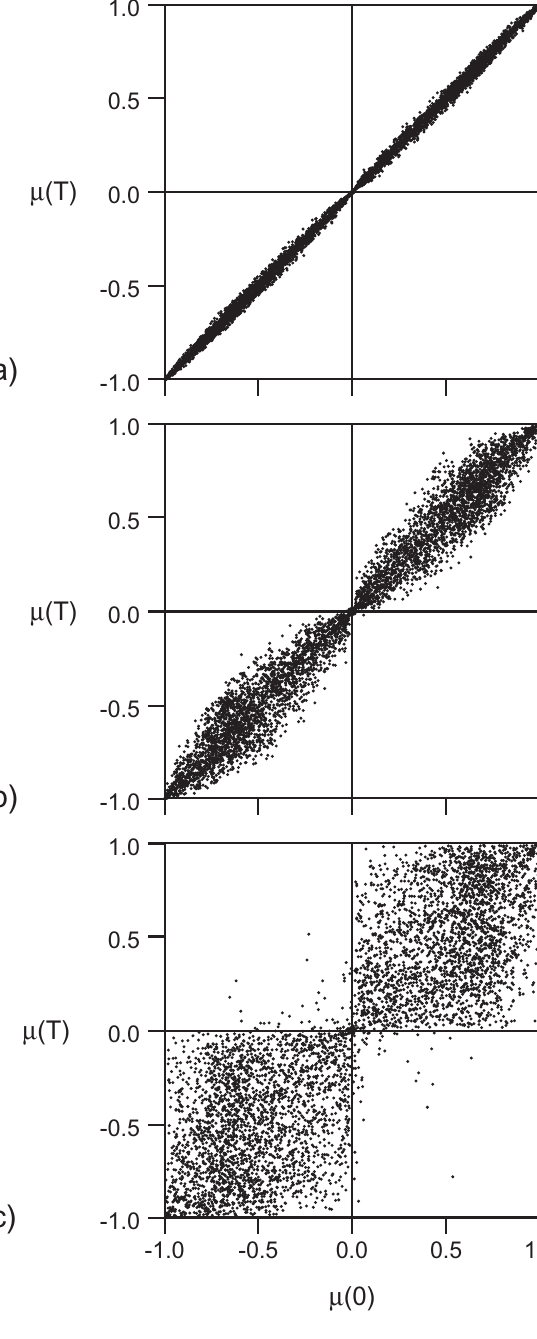
Fig. 15. Particle-In-Cell simulation of time evolution of distribution of ion pitch angle cosine, µ . For each panel, the horizontal axis rep- resents the initial distribution, µ( 0 ) , and the vertical axis denotes the distribution at a later time T . The three panels (a) , (b) and (c) show the distribution at time T = 40, 640 and 10240, respectively. A lack of scattering across 90 ◦ pitch angle is evident from the sim- ulation. See text for more details of the simulation